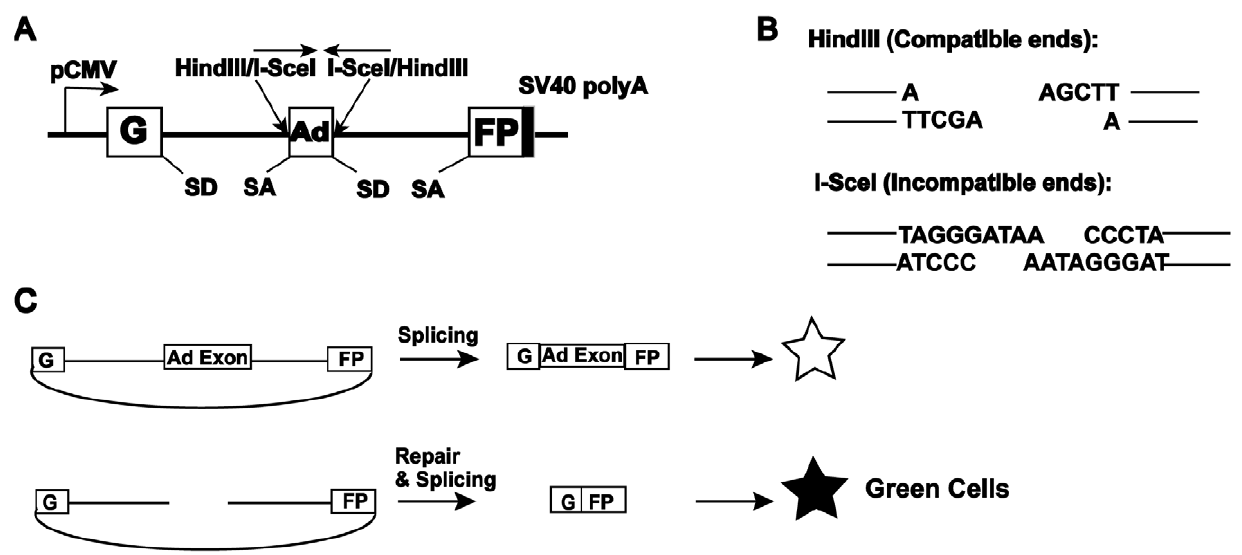
Figure 1. Reporter substrate for analysis of NHEJ. A cartoon of the reporter construct (pEGFP-Pem1-Ad2). (A) The construct is essentially a GFP cassette whose expression is driven by CMV promoter and terminated by the SV40 polyA sequence. ‘‘G’’ is separated from ‘‘FP’’ by a 2.4 kb intron containing an exon (Ad) from adenovirus that is flanked by HindIII and I-SceI restriction sites. Splice donor (SD) and splice acceptor (SA) sites are shown. (B) Restriction sites used to introduce DSBs. Digestion with HindIII generates compatible cohesive ends. Because I-SceI has a nonpalindromic 18-bp recognition site, cleavage of the two inverted I-SceI sites generates incompatible ends. (C) Due to the presence of the Ad-exon into the middle of the Pem1 intron, the Ad exon is efficiently spliced into the middle of the GFP ORF, inactivating the GFP activity and thus making the starting substrate GFP negative. Both sides of the Ad exon have HindIII/I-SceI restriction sites. Cleavage with either of these endonucleases removes the Ad exon and upon successful intracellular plasmid circularization GFP expression is restored and can be quantitated by flow